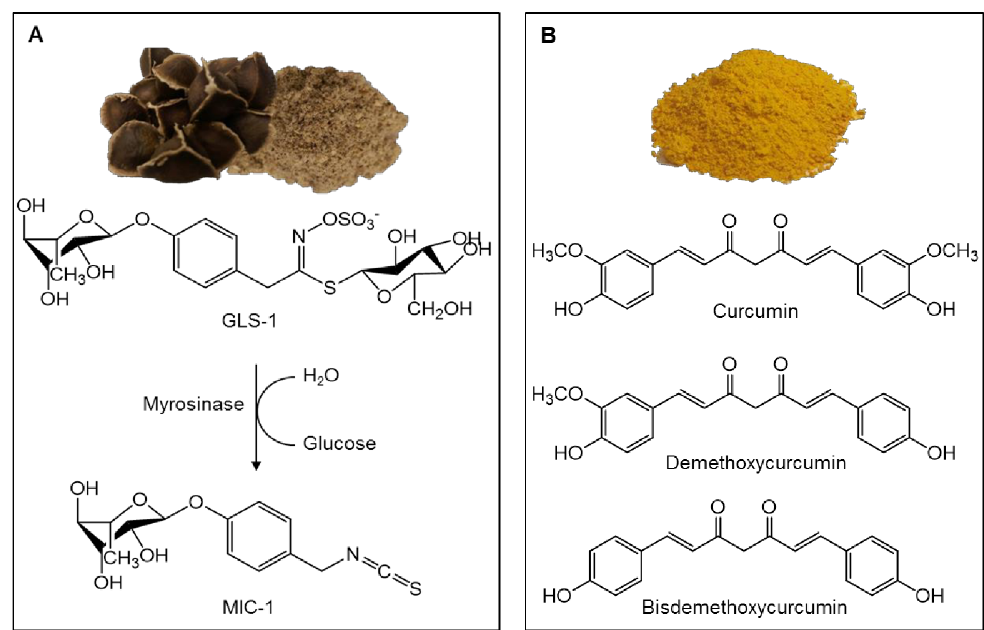
Fig 1. Chemical structuresof the major phytoconstituents from Moringa oleifera (moringa) and Curcuma longa (turmeric). A) Moringa seeds and MSE preparedfrom them and the in situ bioconversion of GLS-1 to the designatedbioactive,MIC-1. B) Curcuma longa extract and chemicalstructures of its three major curcuminoid constituents,curcumin (diferuloylmethane), demethoxycurcumin and bisdemethoxycurcumin.